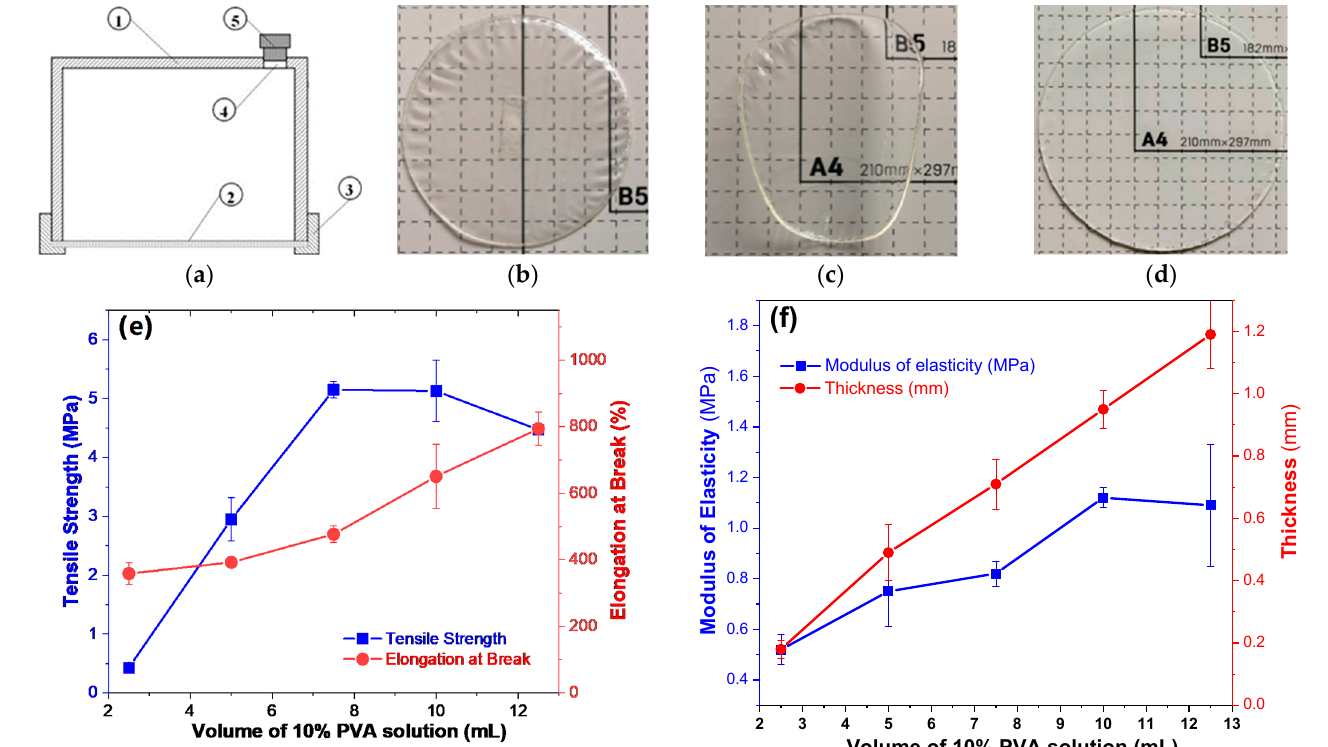
Figure 1. The schematic structure of the UND mold ( a ), the appearance of PVAHMs ( b – d ), and the effects of the PVA level on the mechanical properties and thickness of PVAHMs ( e , f ). ( a ) 1—Cup body; 2—nanopore filter membrane; 3—fixing flange ring; 4—hole of sample feeding; 5—rubber plug. ( b – d ) Images of a PVA membrane in semi-dry, dry, and swollen states in water at equilibrium (24 h); the size of the small squares in the background of figures is 10 mm × 10 mm. ( e , f ) The evolution of some of the mechanical properties of the PVAHM in the semi-dry state (30 mm × 5 mm rectangular strips) as a function of the initial volume of the PVA solution used for membrane preparation ( n = 5).